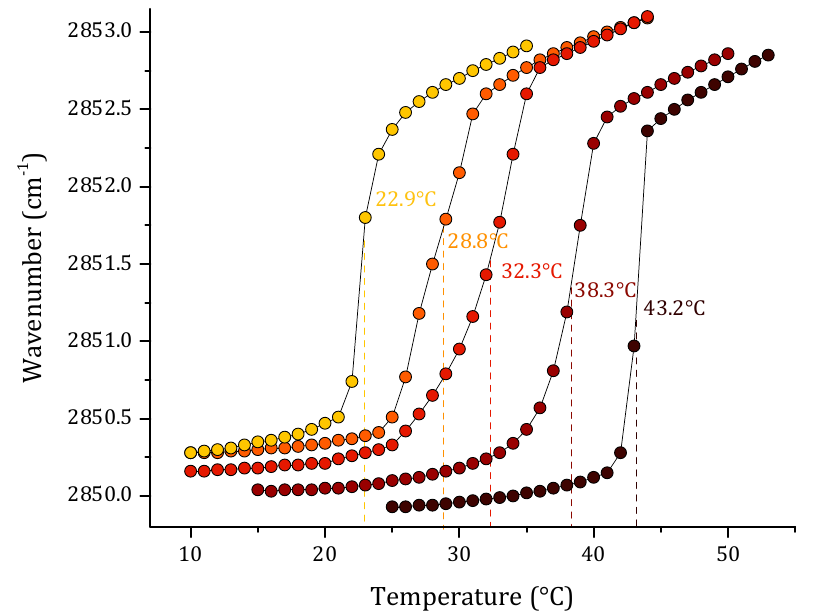
Figure 5. Peak positions of the ν s CH 2 vibration bands of the methylene groups as a function of temperature of ( • ) DMPG, ( • ) DMPG:CL (80:20), ( • ) DMPG:CL (70:30), ( • ) DMPG:CL (60:40), and ( ) CL in Buffer (20 mM Hepes, 500 mM NaCl and 1mM EDTA).